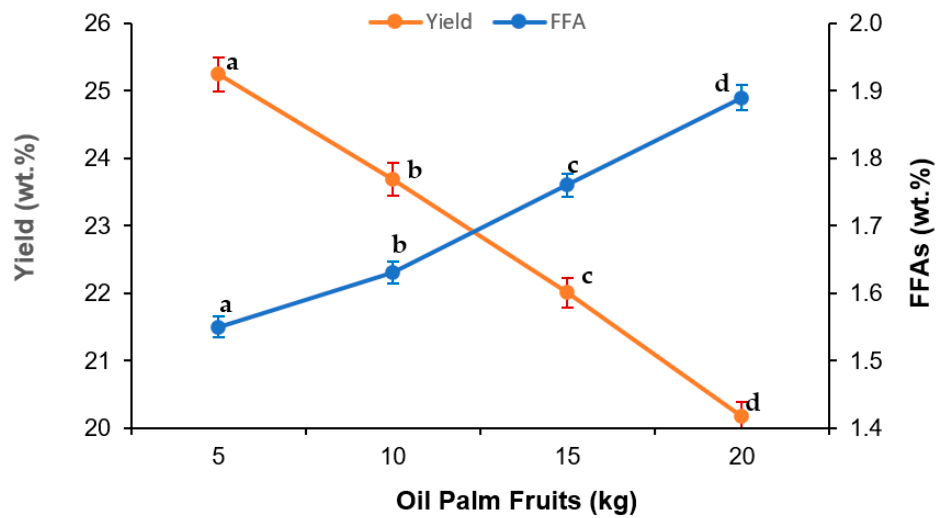
Figure 4. Effect of the amount of fresh fruit sterilization in VPO extraction using cold press technology. Experimental conditions: temperature 60 °C, time 60 min. Means of triplicates ± standard deviation. Means followed by different letters in the same line demonstrated significant difference by Tukey test ( p < 0.05).